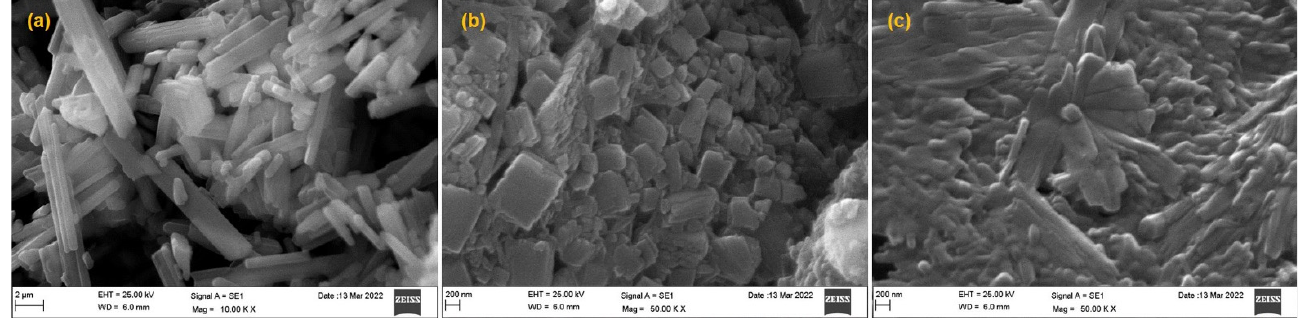
Figure 2. Scanning electron micrographs of pure OLA ( a ); OLA-NCs-2 prepared with 0.5%, w/v of Soluplus ® as stabilizer ( b ) and OLA-NCs-2 freeze-dried with mannitol ( c ).